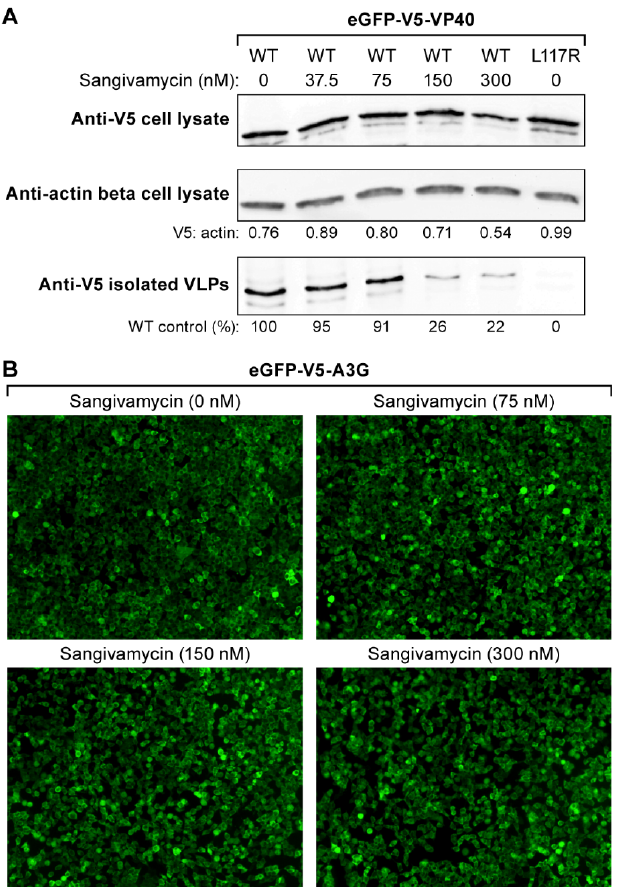
an initial indicator of cell health (bottom panels). ( B ) The table lists the top 30 hits by their NCI assigned NSC numbers. Sangivamycin as either its HCl salt (NSC 143648) or free base (NSC 65346) impairs EBOV VP40 localization to the inner plasma membrane. Listed are the half maximal ef- fective concentration (EC 50 ), drug concentration required to reduce cell viability by 50% (CC 50 ), and selectivity index (SI) values of the 30 hits identified in the primary screening and evaluated in the secondary screening. EC 50 values were quantified by plate reads compared to VP40 WT and VP40 L117R positive control values. CC 50 values were measured with CellTiter-Glo as relative luciferase units compared to VP40 WT and VP40 L117R positive control and SI was calculated by CC 50 /EC 50 . Although initial quantification was performed by plate reader, all hits were confirmed by a phenotypic shift from fluorescent rings to homogenous expression by cellular imaging. ( C ) Representative fluorescent images of VP40 WT treated with 37.5, 75, 150, and 300 nM sangivamycin at 10 × magnification.